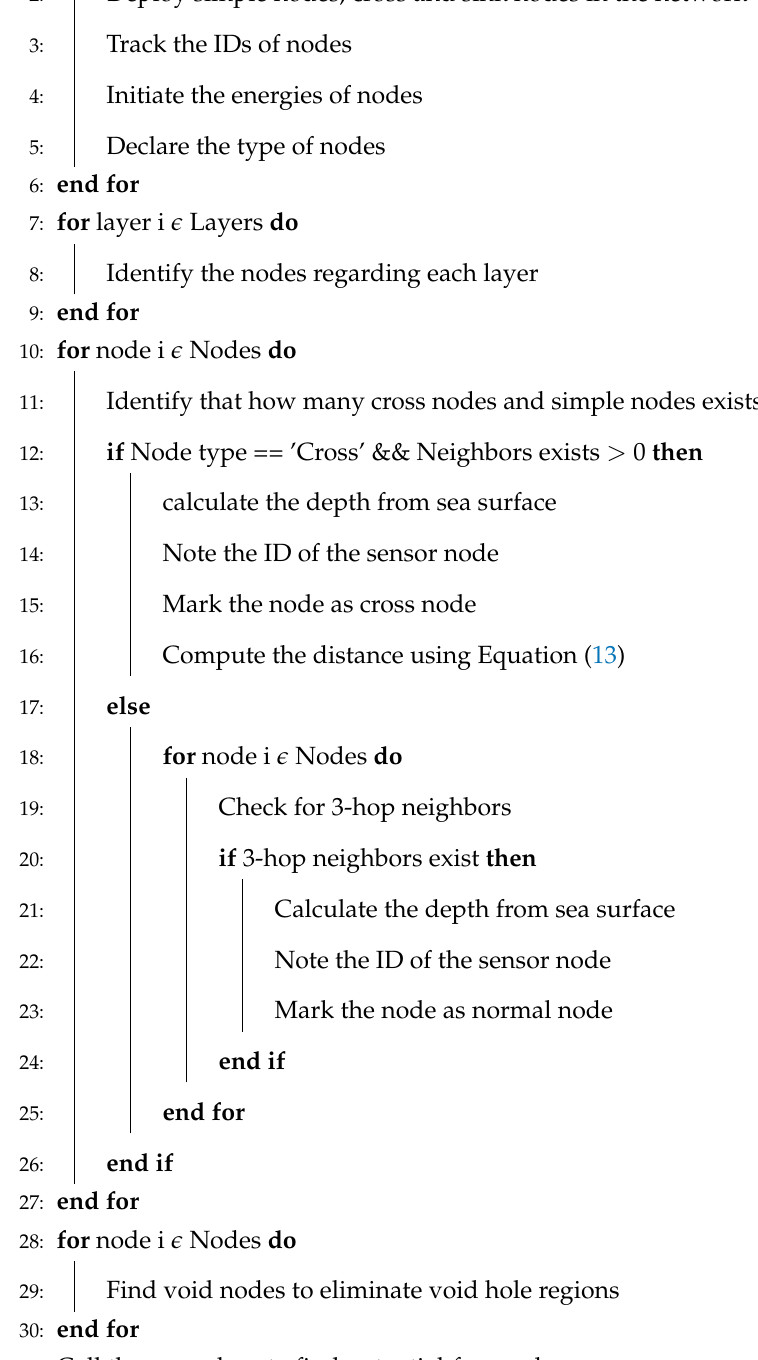
Algorithm 1 SPF-Three